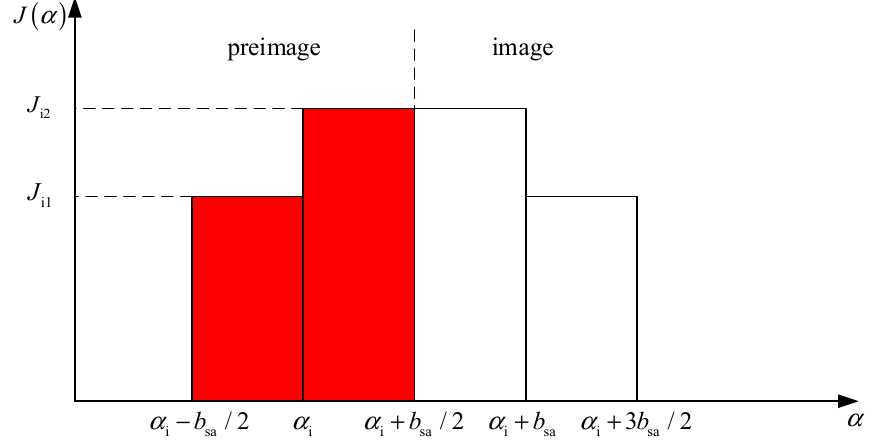
Figure 9. Stator slot current density distribution.